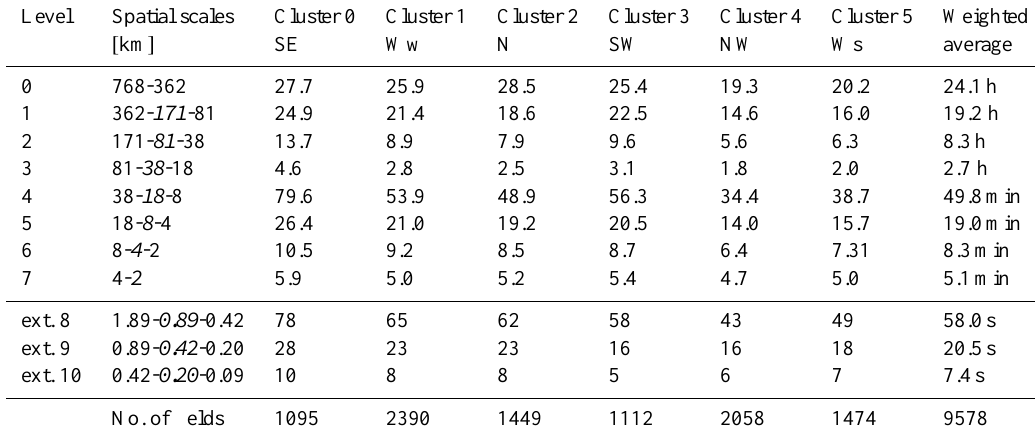
Table 2. Precipitation lifetimes for each spatial scale and flow regime averaged over the radar composite. Levels 0–3 are expressed in hours and 4–7 in minutes. The power law extrapolation of lifetimes for smaller spatial scales is given in seconds. Ext.: estimation of the lifetimes at smaller spatial scales by extrapolating the power law. The extrapolation uses the original non-integer scales for increased precision. The scales on which the Gaussian filters are centered are marked in